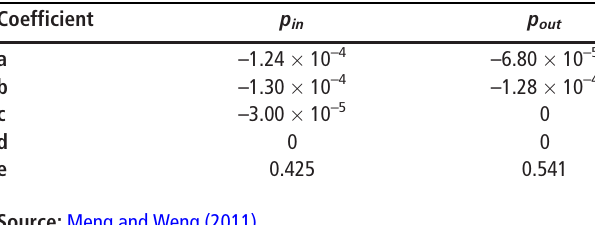
Table II Parameters in randomization probability